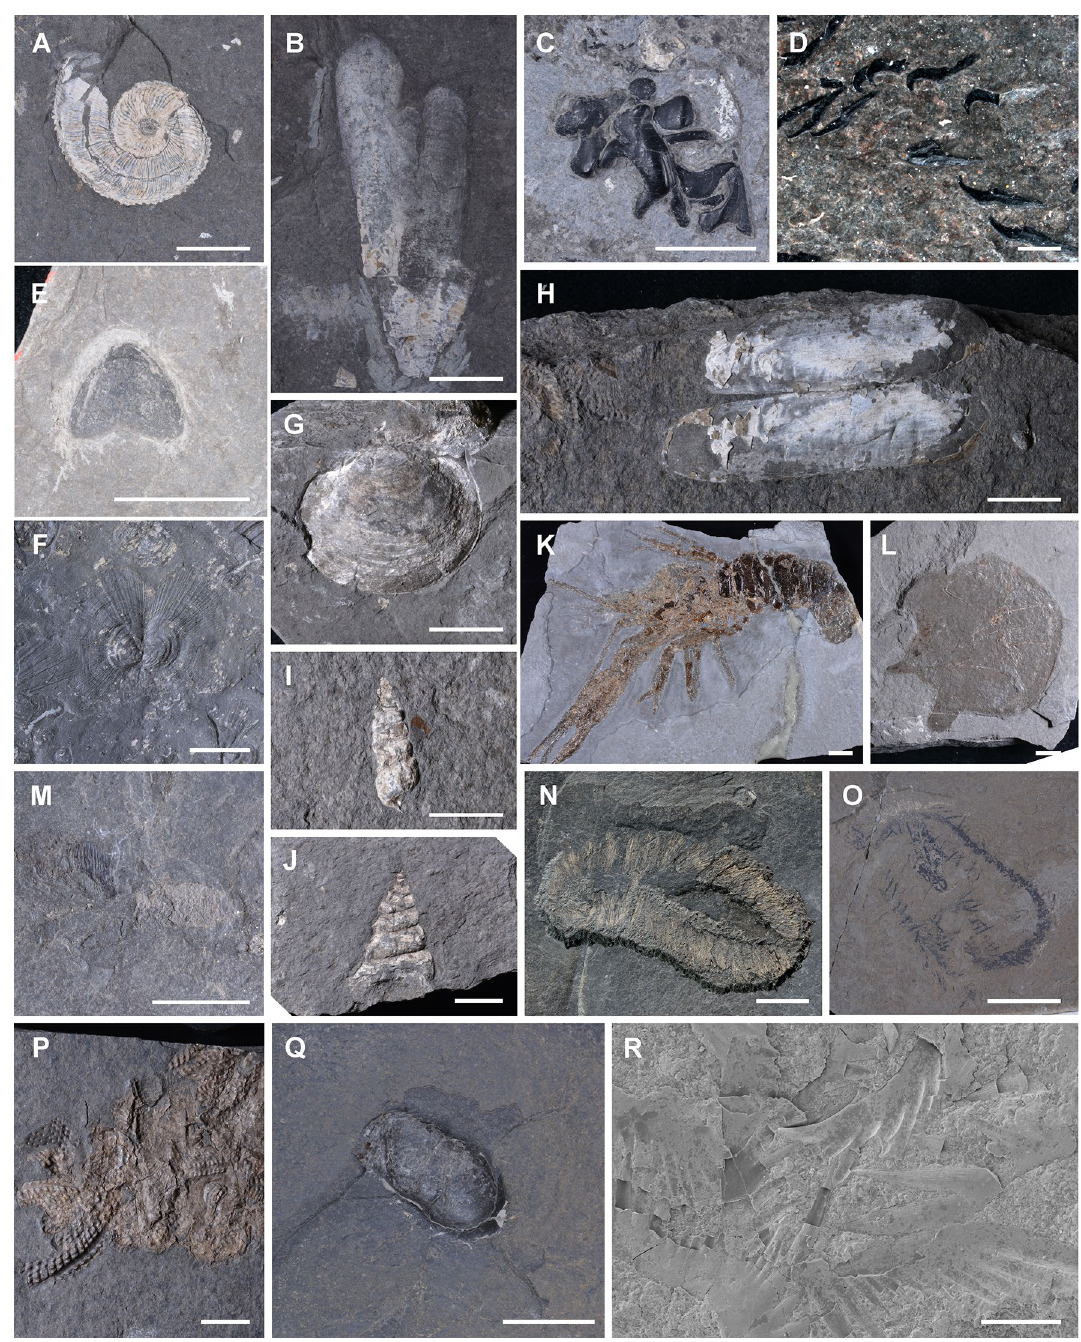
Figure 3. Invertebrate members of the Lower Carnian (Upper Triassic) Polzberg palaeobiota. ( A ) Austrotrachyceras minor , lateral view, NHMW 2021/0001/0001; ( B ) Phragmoteuthis bisinuata , NHMW 2006z0235/0006; ( C ) fragments of teuthid cartilage, NHMW 2021/0001/0002; ( D ) teuthid arm hooks, NHMW 2021/0001/0003; ( E ) Anaptychus lunzensis var. lata , NHMW 2021/0001/0004; ( F ) Halobia rugosa , note the butterfly preservation, NHMW 2021/0001/0005; ( G ) Bivalve indet, NHMW 2012/0228/0010; ( H ) Bivalve indet, note the butterfly preservation, NHMW 2012/0228/0011; ( I ) Gastropoda indet, NHMW 2012/0228/0012; ( J ) Gastropoda indet, 2012/0228/0013a; ( K ) Platychela trauthi , NHMW 1910/0015/0018; ( L ) Austriocaris carinata , NHMW 1910/0015/0050; ( M ) Atropicaris striata , NHMW 2021/0001/0006a; ( N ) Palaeoaphrodite sp. , NHMW 2018/0103/0003a; ( O ) eunicid polychaete, NHMW 2021/0001/0007a; ( P ) entire regurgitalite, exhibiting fragmented ammonite remains of Austrotrachyceras minor , ammonite fragments in external and lateral view, NHMW 2020/0033/0005; ( Q ) entire coprolite, exhibiting actinopterygian fish remains, NHMW 2020/0033/0028a; ( R ) micro-coprolite, exhibiting conodontophorid remains as cluster, NHMW 2012/0117/0023. Scale bar: 10 mm, except ( R ) scale bar: 100 μm. Prepared by AL using CorelDRAW X7; www. corel draw.